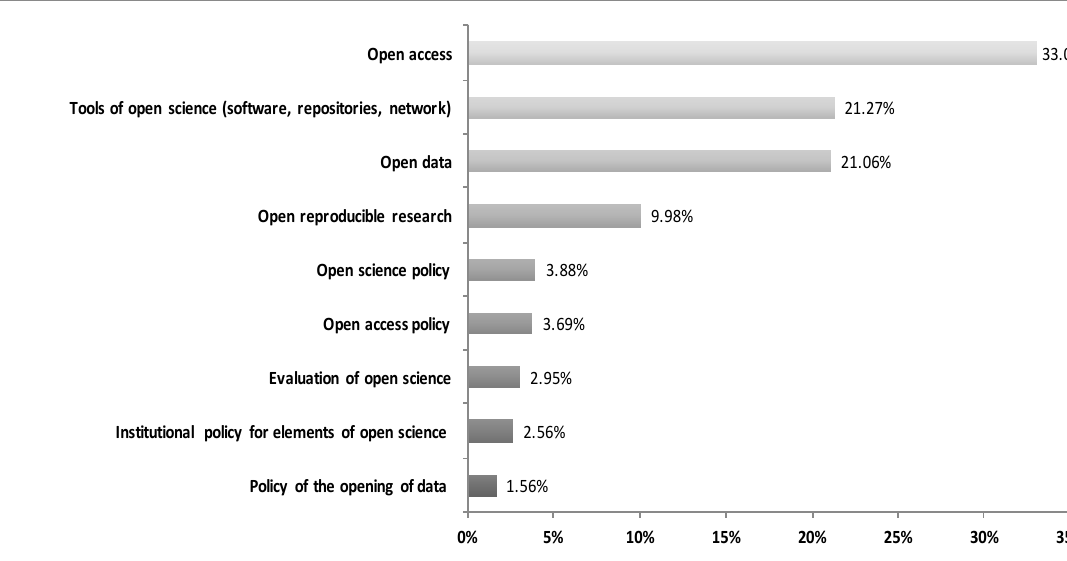
Figure 3. Elements of open science most used by Colombian researchers.